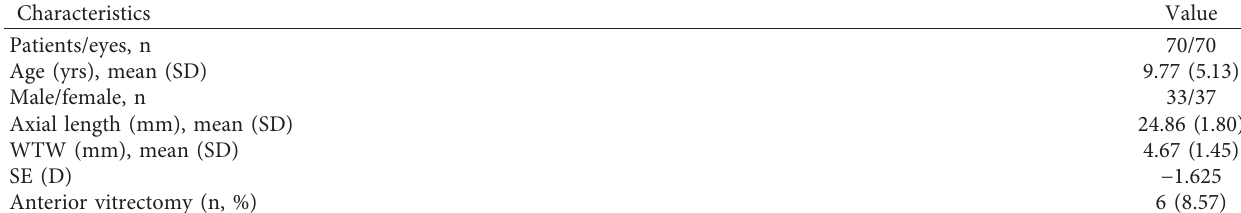
Table 1: The demographic and clinical features of 70 CEL